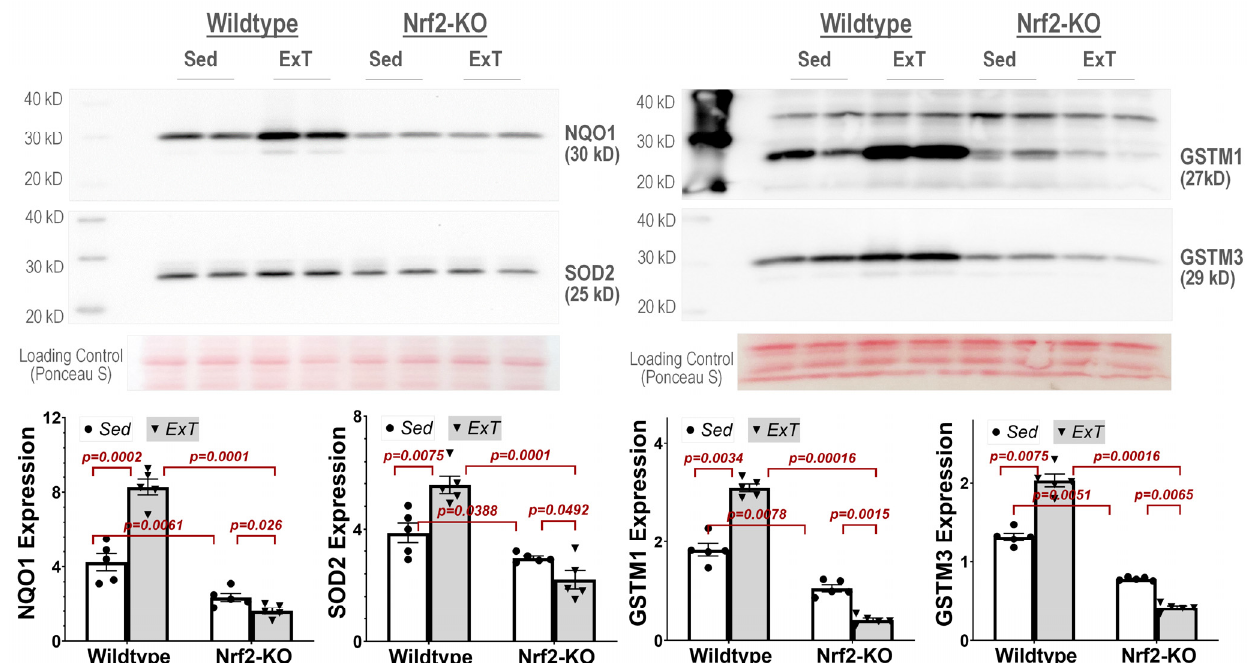
Figure 8. Western blotting shows that NQO1, SOD2, GSTM1, and GSTM3 are upregulated in WT-ExT and downregulated in KO-ExT as compared to Sed controls. n = 5/group.